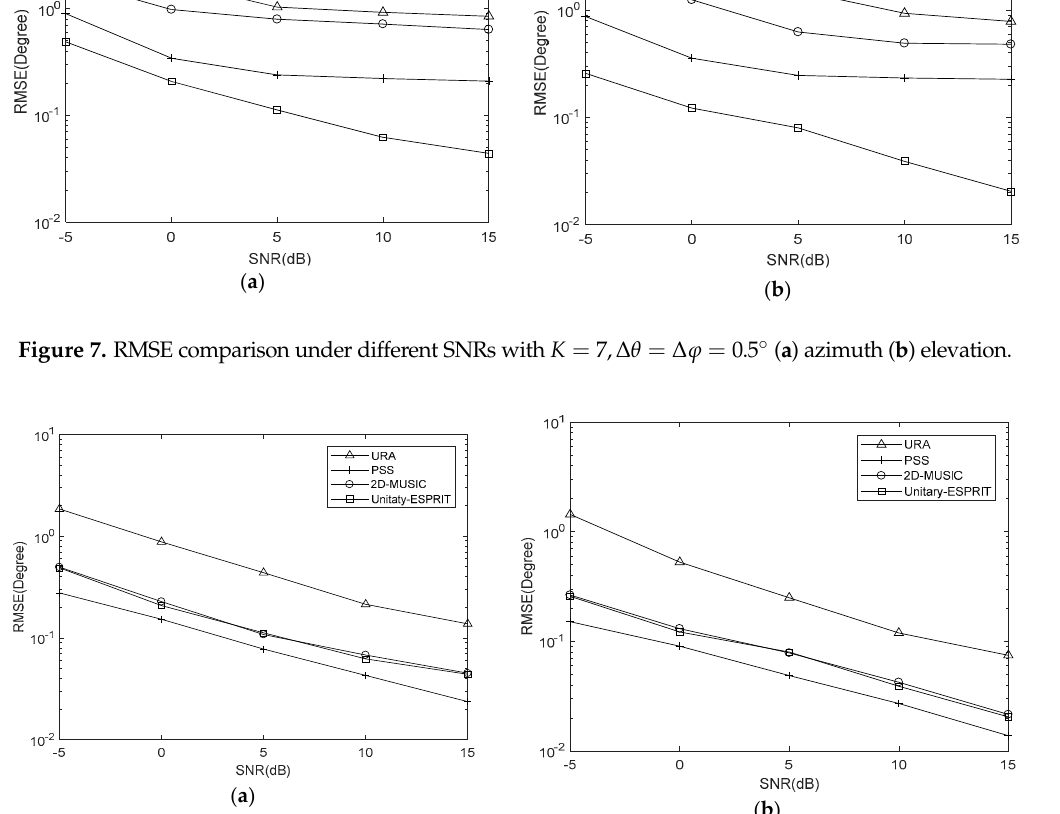
Figure 7. RMSE comparison under different SNRs with Figure 8. RMSE comparison under different SNRs with Figure 8. RMSE comparison under different SNRs with K = 7, ∆ θ = ∆ ϕ = 0.05 ◦ ( a ) azimuth ( b ) elevation. Figure 8. RMSE comparison under different SNRs with elevation.